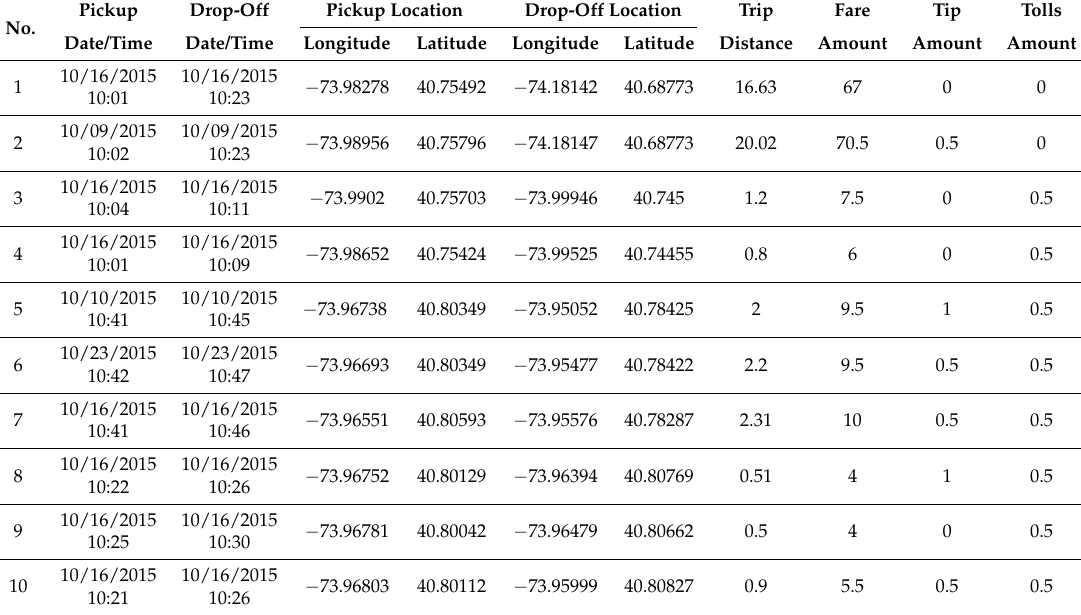
Table 2. Taxi Trip